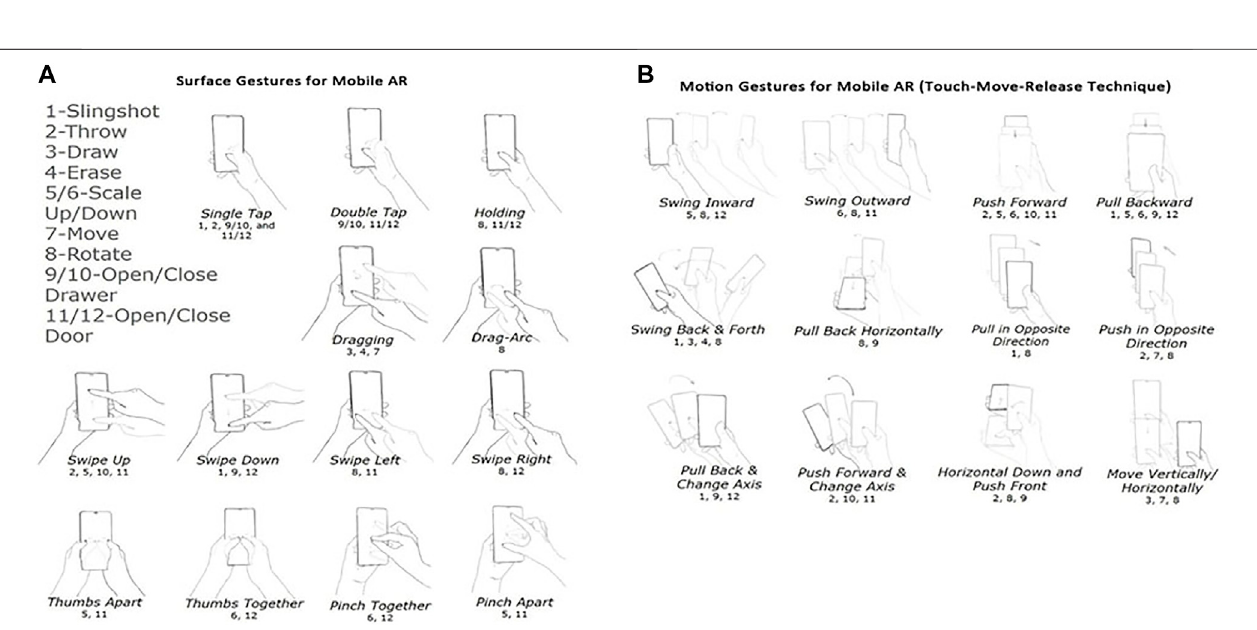
FIGURE3| Twosetsofuser-de fi nedgestures,surfacegesturesformobileAR (A) ,motiongesturesformobileAR (B) .Motiongesturesdemonstratetheconceptof TMR (Touch-Move-Release) interaction technique.